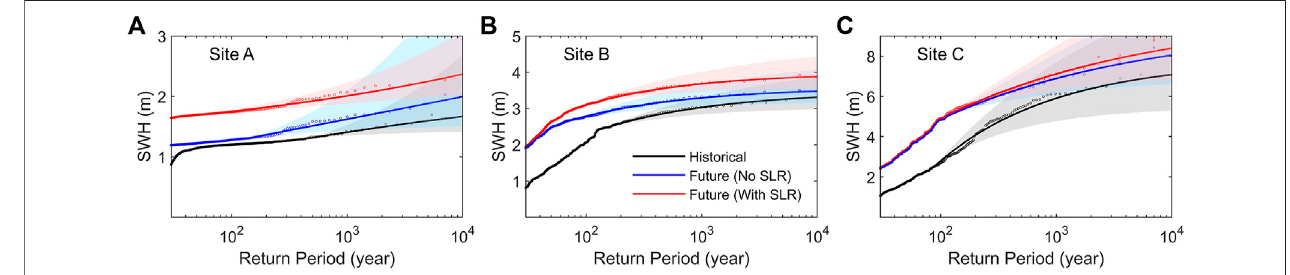
FIGURE 11 | Return periods of SWHs for the three sites along the Atlantic City cross-shore pro fi le ( Figure 1 for the site location). Shaded areas cover the 90% statistical con fi dence interval (5th to 95th percentiles). Dots are data points.